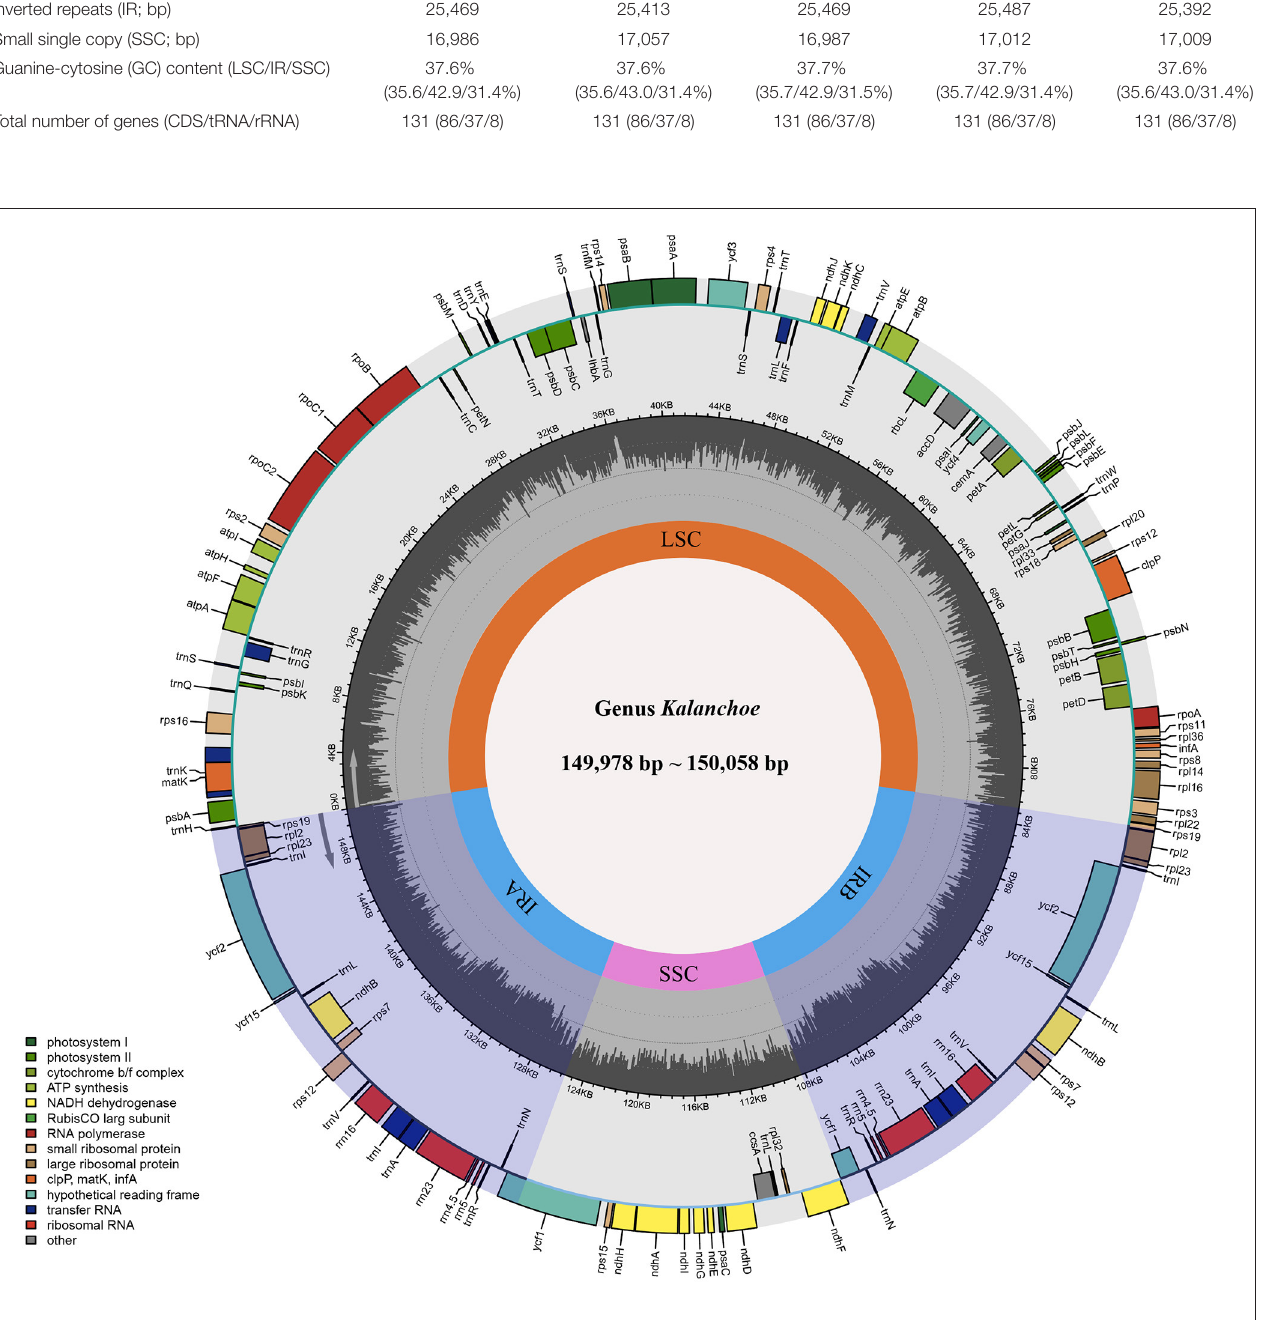
FIGURE 1 | Gene map and genome organization of the five Kalanchoe plastomes. It exhibits a typical quadripartite structure with a pair of inverted repeat regions (IRA and IRB) separating the small single-copy region (SSC) and the large single-copy region (LSC). Functional genes are also included and color-coded in this map, and guanine-cytosine (GC) contents are